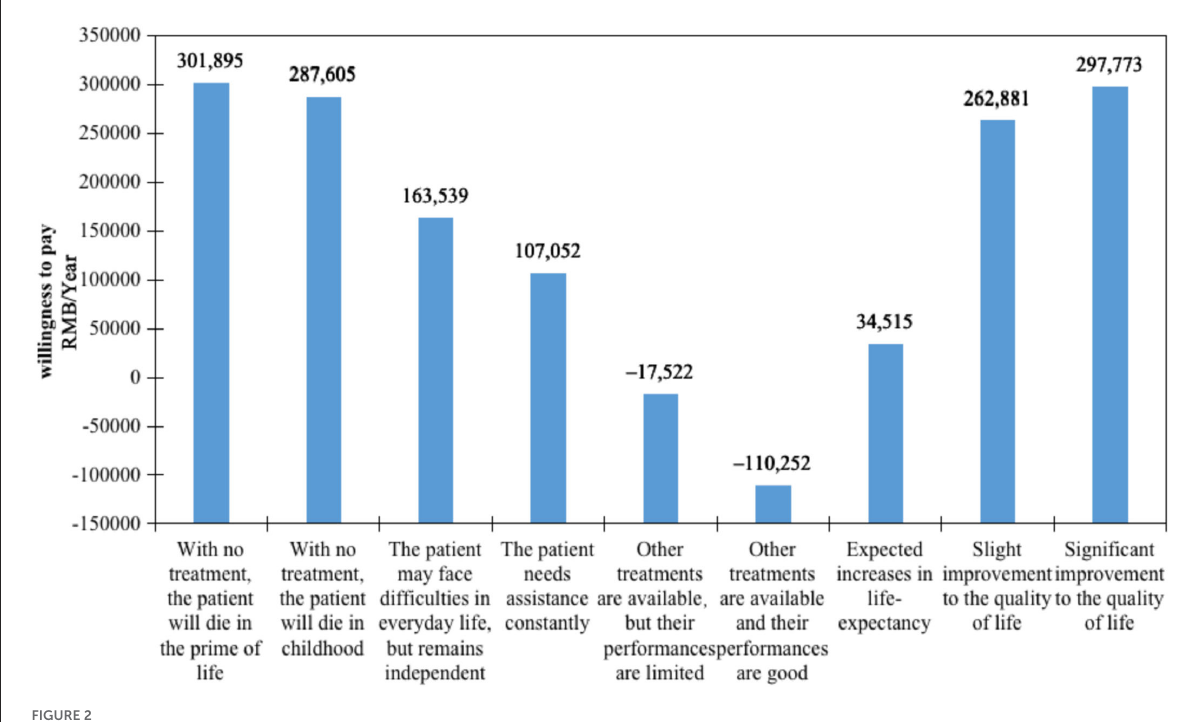
FIGURE2 Willingness to pay for attributes of orphan